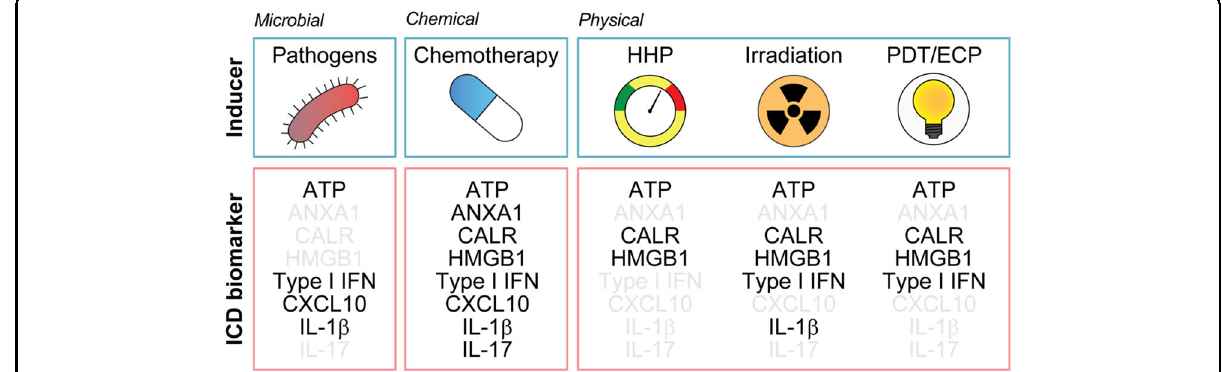
Fig. 1 Main hallmarks of ICD. Different inducers of immunogenic cell death (ICD) have been shown to elicit incompletely overlapping molecular signatures with respect to ICD biomarkers. This not only reinforces the need for the simultaneous assessment of multiple surrogate ICD biomarkers in the context of screening campaigns, but also identi fi es an originally unsuspected diversity in the molecular and cellular mechanisms supporting adaptive immunity downstream of danger signaling. ANXA1, annexin A1; CALR, calreticulin, CXCL10, C-X-C motif chemokine ligand 10; ECP, extracorporeal photochemotherapy; HHP, high hydrostatic pressure; HMGB1, high-mobility group box 1; IFN, interferon; IL-1 β (of fi cial name: IL1B), interleukin 1 beta; IL-17 (of fi cial name: IL17), interleukin 17; PDT, photodynamic therapy.